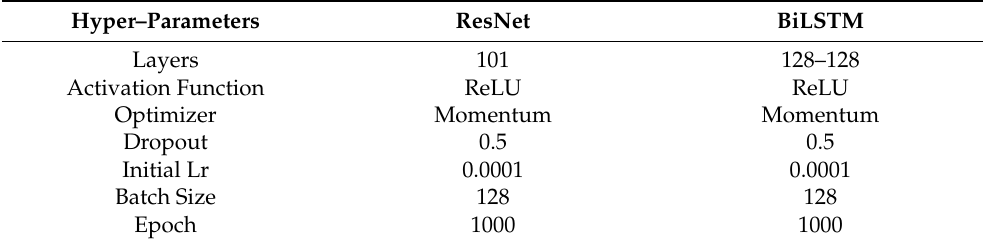
Table 4. Hyper–parameters of our model for the dataset .